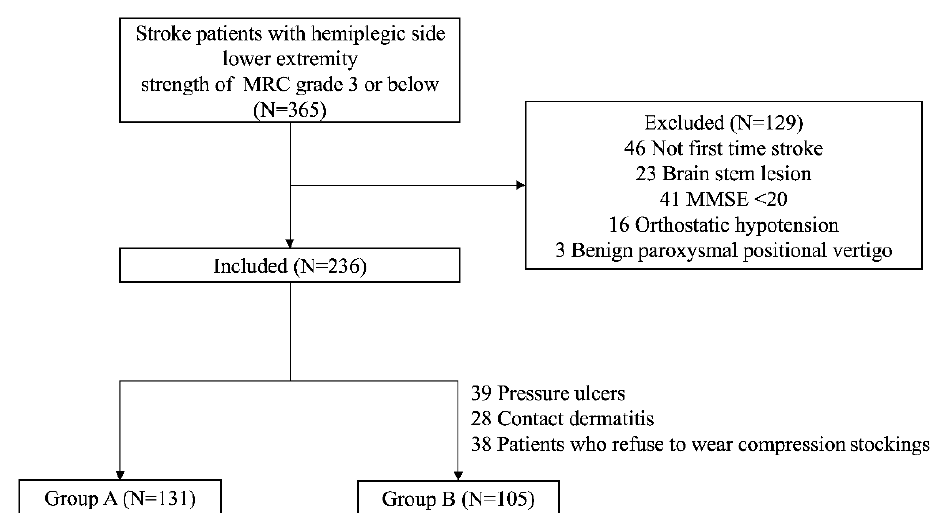
Figure 1. Flow chart of study participant enrollment.